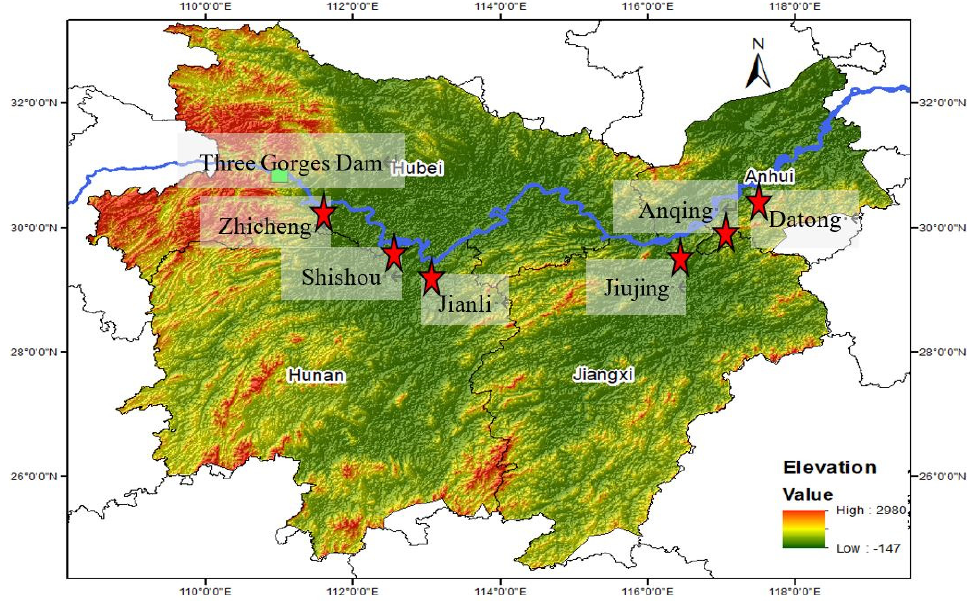
Figure 1. Study area—locations of 4 provinces and 6 hydrological stations represented by stars.